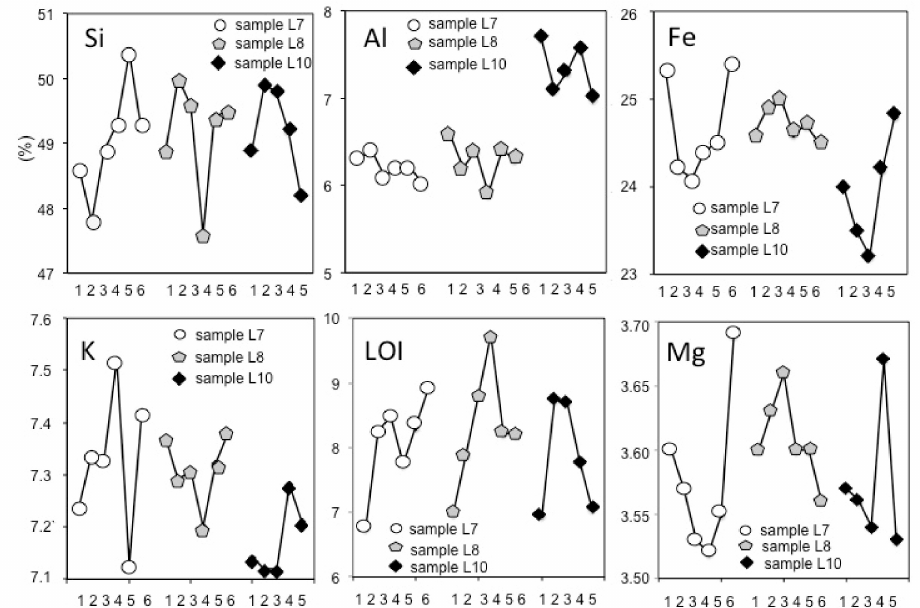
Figure 1. The analytical variations of the major elements leached from the three L7, L8 and L10 glauconite separates by the different ultrasonic leaching experiments. The numbers at the bottom of each diagram refer to the different aliquots of each sample in Table 1. LOI stands for loss of